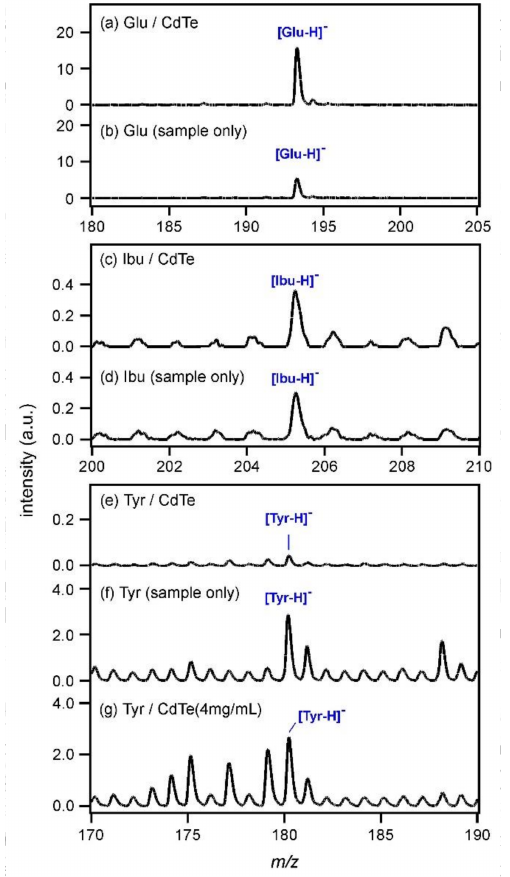
Figure 2. Mass spectra of glucuronic acid (Glu) ( a ) with CdTe nanoparticles as the matrix and ( b ) without matrix. Mass spectra of ibuprofen (Ibu) ( c ) with CdTe and ( d ) without matrix. Mass spectra of tyrosine (Tyr) ( e ) with CdTe, ( f ) without matrix, and ( g ) with CdTe (4